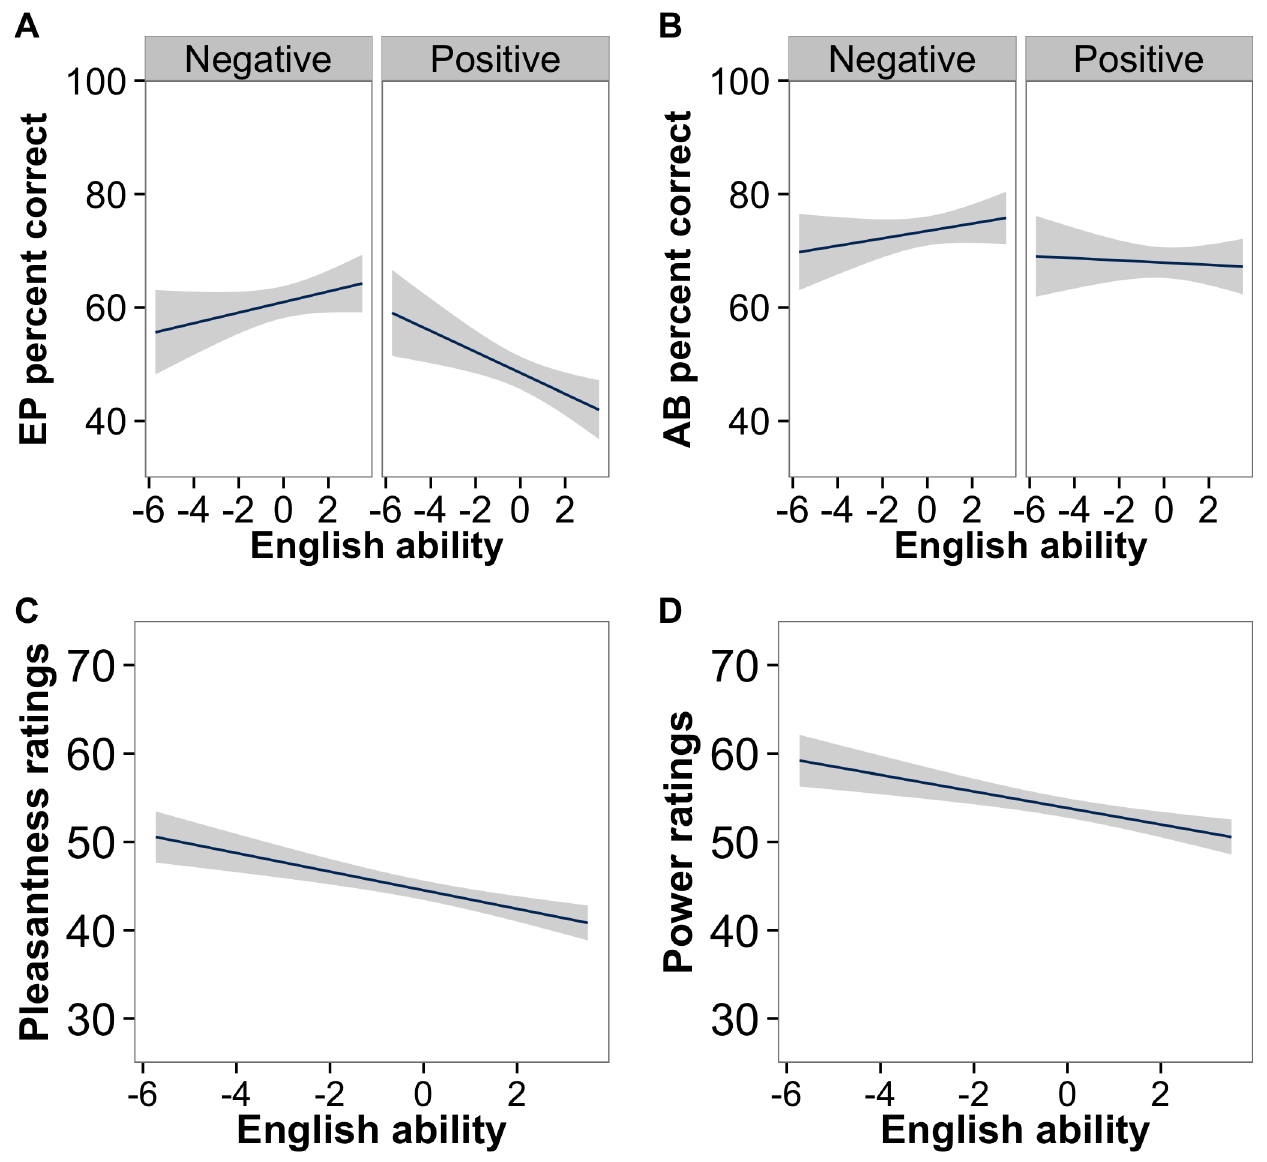
Fig 2. Linear regressions of percent correct responses by English ability for positive and negative emotions in the a) emotional prosody and b) affect burst conditions and of of c) pleasantness and d) power ratings by English ability in the emotional prosody condition. Shaded areas indicate standard